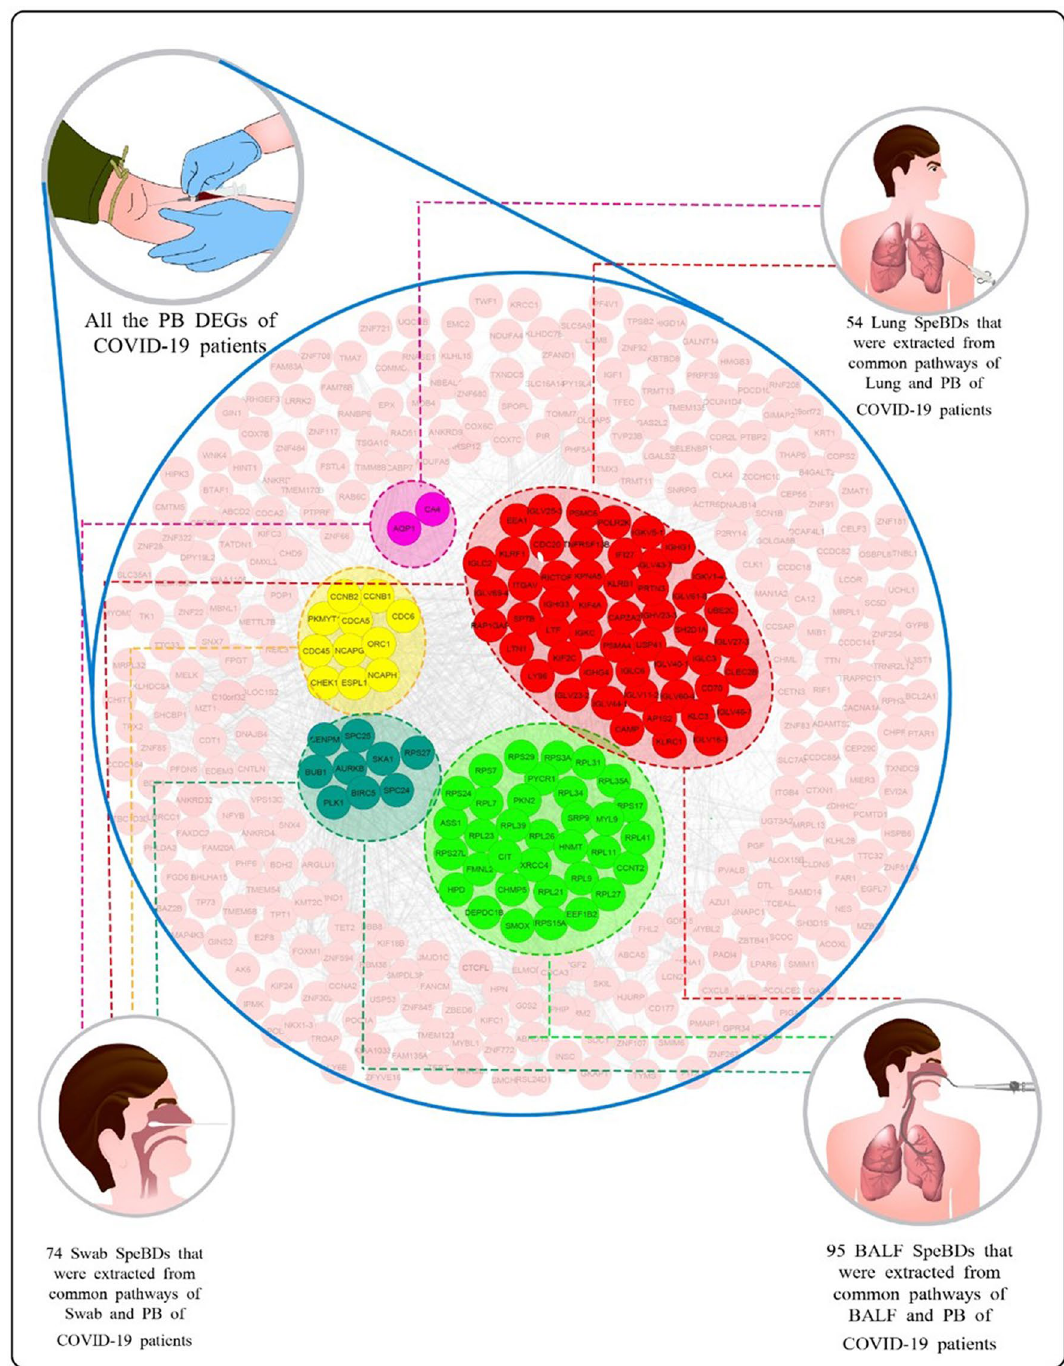
Figure 3. Extraction of SpeBDs from PB DEGs of COVID-19 patients with the help of the common pathways between PB and the three sources from the respiratory system of COVID-19 patients (Swab, BALF, and Lung). A whole list of SpeBDs is indicated in this figure. Lung, Lung tissue biopsy; Swab, nasopharyngeal swab; BALF, bronchoalveolar lavage fluid; PB, peripheral blood. The figure is created using Cytoscape version 3.8.2 and Illustrator version